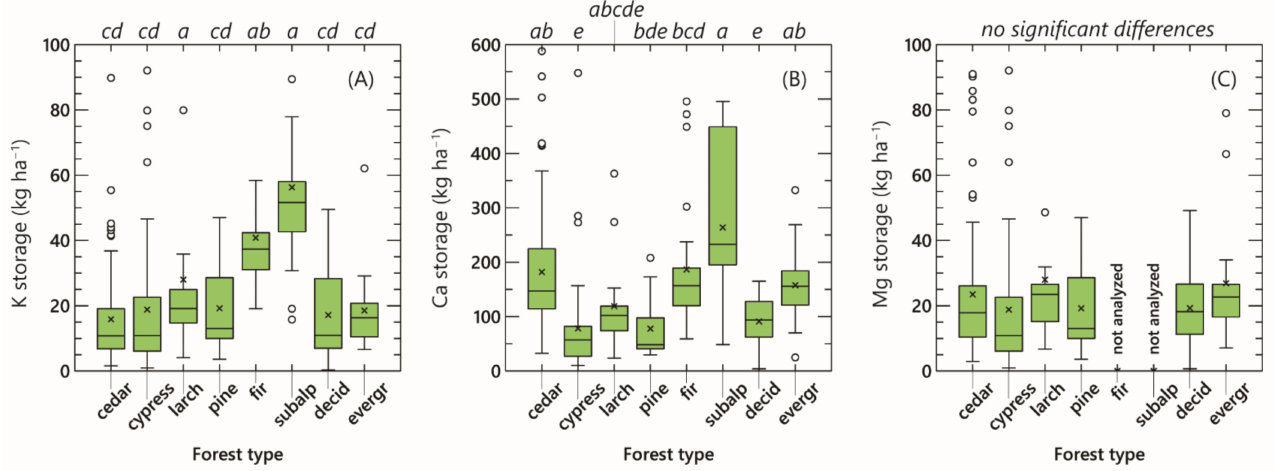
Figure 3. Box and whisker plots of potassium ( A ), calcium ( B ), and magnesium ( C ) storage in the forest floor among Japanese forest types. The definitions of box and whisker are the same as those used in Figure 2. Different lowercase letters on the figure denote significant differences between forest types at p < 0.05 based on the Steel–Dwass